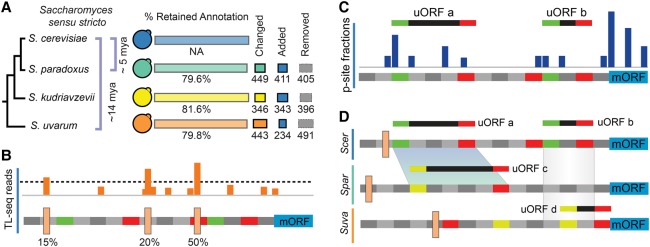
Overview. (A) The genomes of nonmodel species were reannotated to include ncRNA and correct previous errors, resulting in changes to ∼20% of genes on average (Methods). (B) Transcript leaders and polyadenylation sites were annotated for four Saccharomyces sensu stricto species using TL-seq (Arribere and Gilbert 2013) and pA-seq (Yoon and Brem 2010). TL-seq and pA-seq peaks were trend filtered for FDR control (β = 0.001) and evaluated for their usage frequency. (C) Ribosome profiling data from S. cerevisiae, S. paradoxus, and S. uvarum were analyzed to quantify the locations of ribosome P-site occupancy (dark blue peaks). These results were used to identify candidate uORFs. (D) Candidate uORFs were evaluated and scored using the uORF-seqr machine learning algorithm. uORFs with significant scores were retained for further analysis. The transcript leaders of gene homologs were aligned to identify uORF homologs (marked by shaded maps). These were identified by both local sequence alignment (uORFs a and c) and by positional overlap (uORFs b and d).